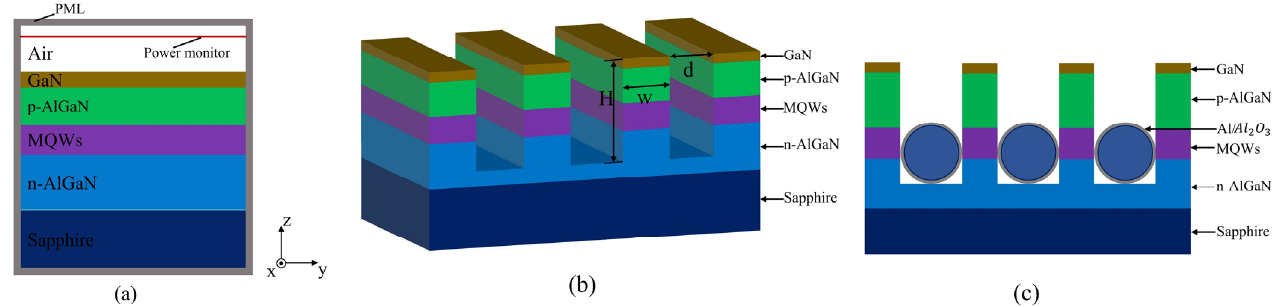
Figure 1. Schematic diagrams of the simulated ( a ) planar structure, ( b ) nanopillar structure and ( c ) Al nanosphere structure.